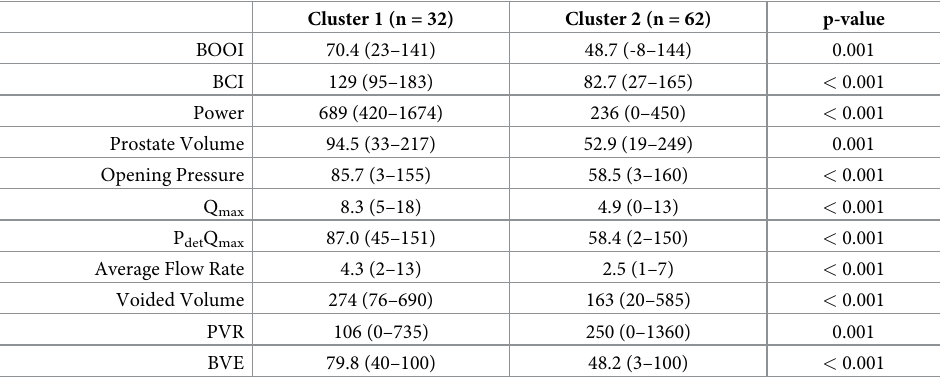
Table 1. Mean (and range) of urodynamic data and prostate volume for Clusters 1 and